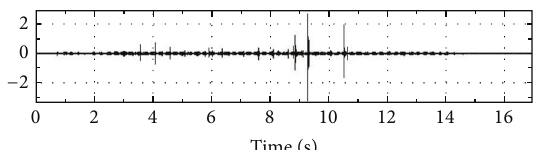
Figure 27: Effective microseism signals from 4# sensor in condition 29.